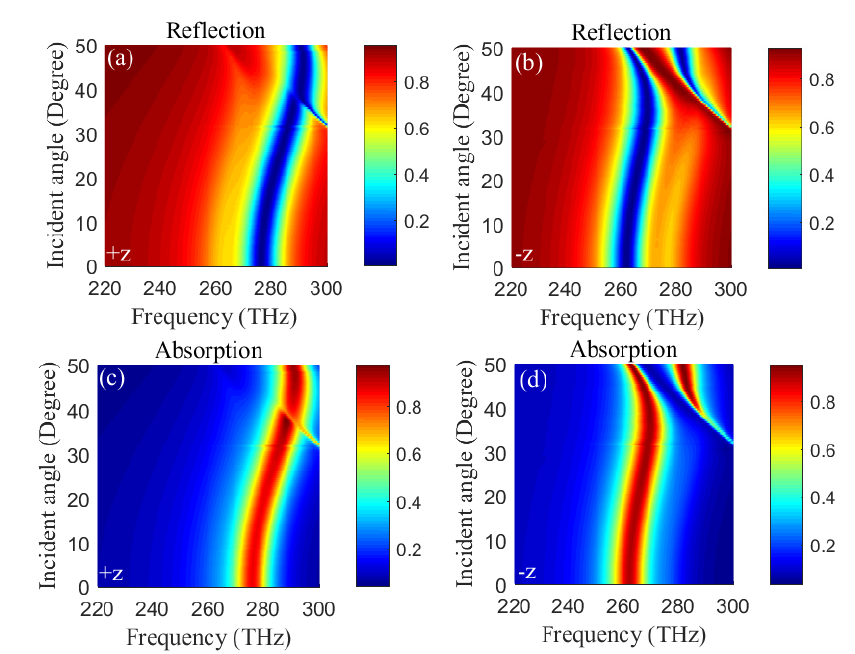
Figure 6. (Color online) Reflections (Absorptions) as the functions of frequency ω and incident angle θ in +z ( a ) and − z ( b )(+z ( c ) and − z ( d )) directions when s = 275